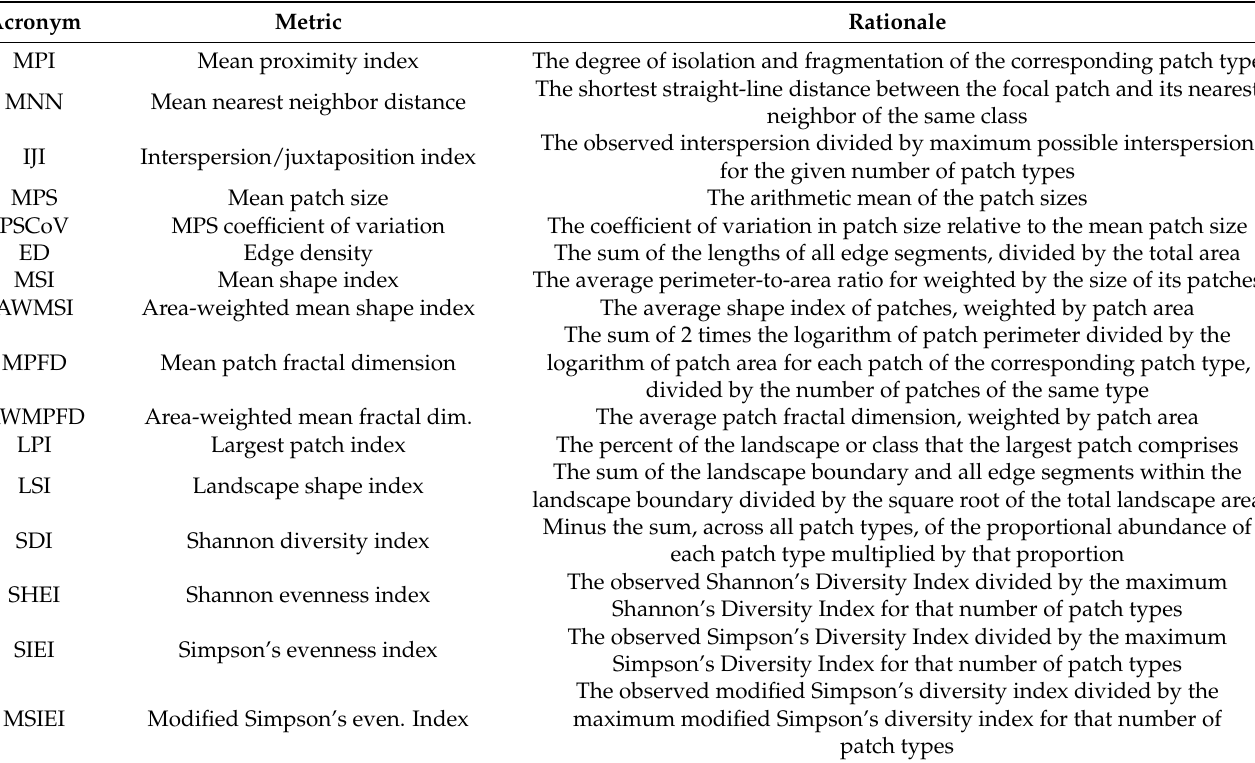
Table 1. List of landscape metrics used to study the spatial distribution of land vulnerability to degradation in